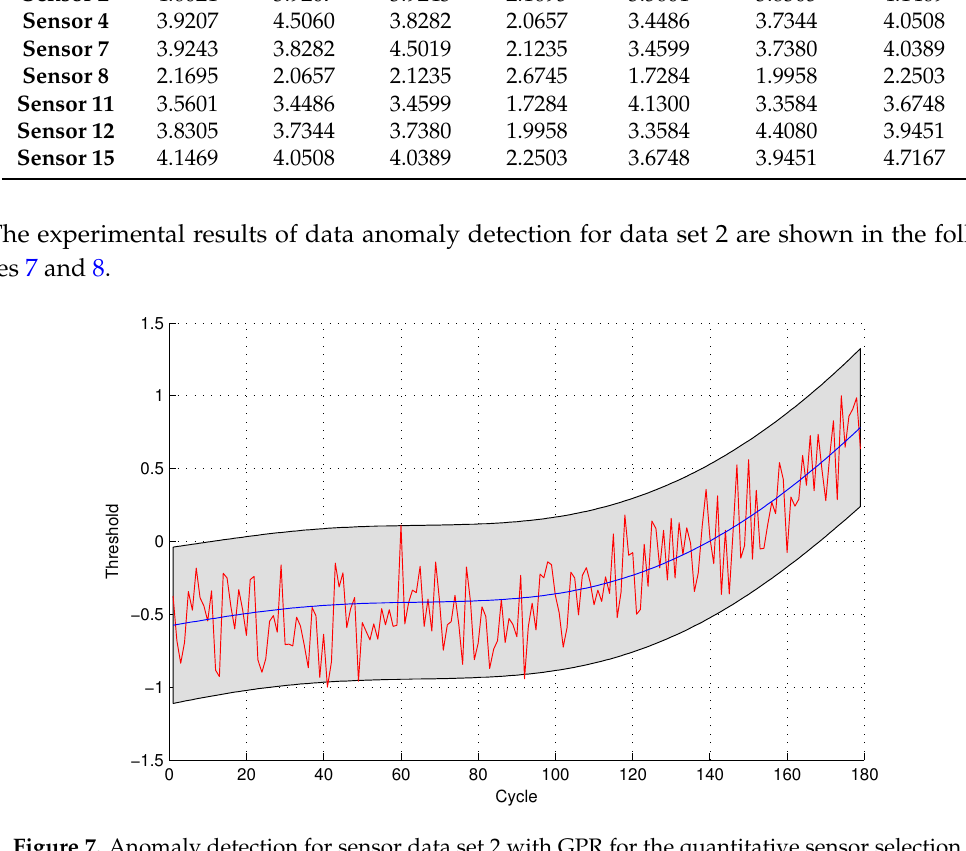
Figure 7. Anomaly detection for sensor data set 2 with GPR for the quantitative sensor